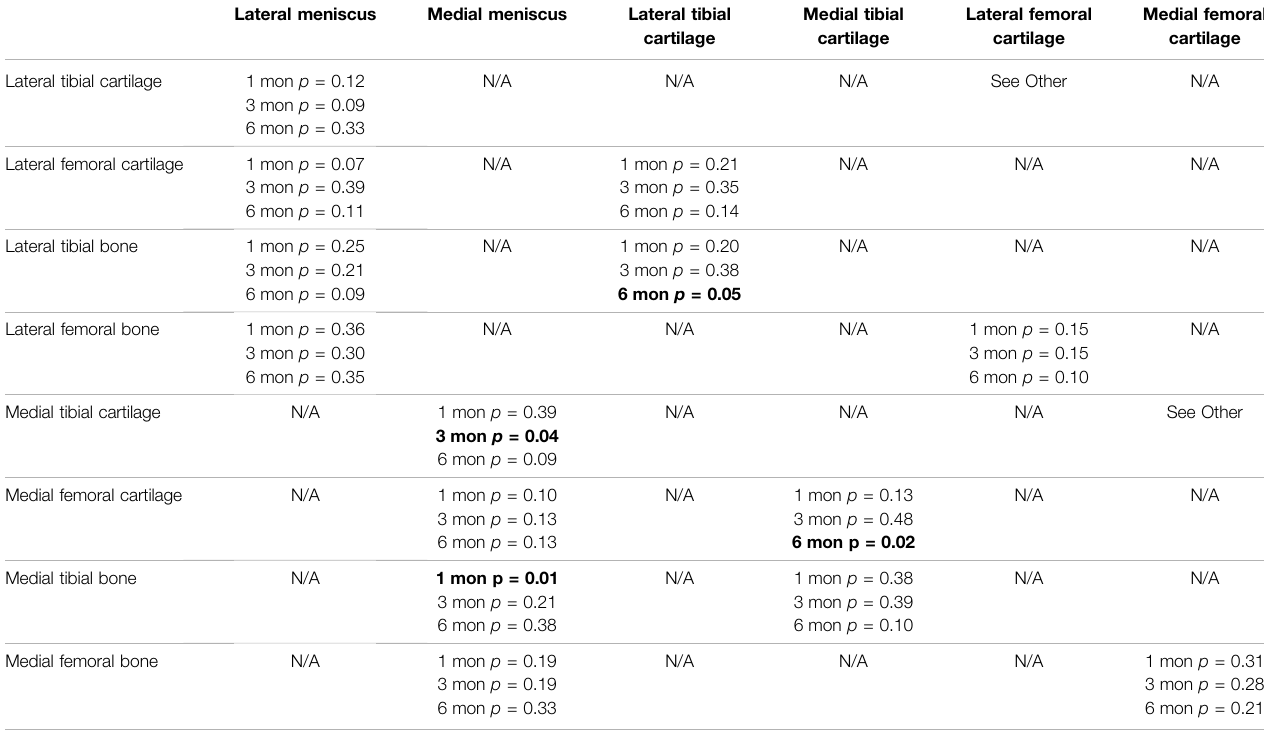
TABLE 2 | Statistical values for all correlations between menisci, cartilage and subchondral bone for all comparisons at 1 month (mon), 3 and 6 months. Lateral meniscus Medial meniscus Lateral tibial